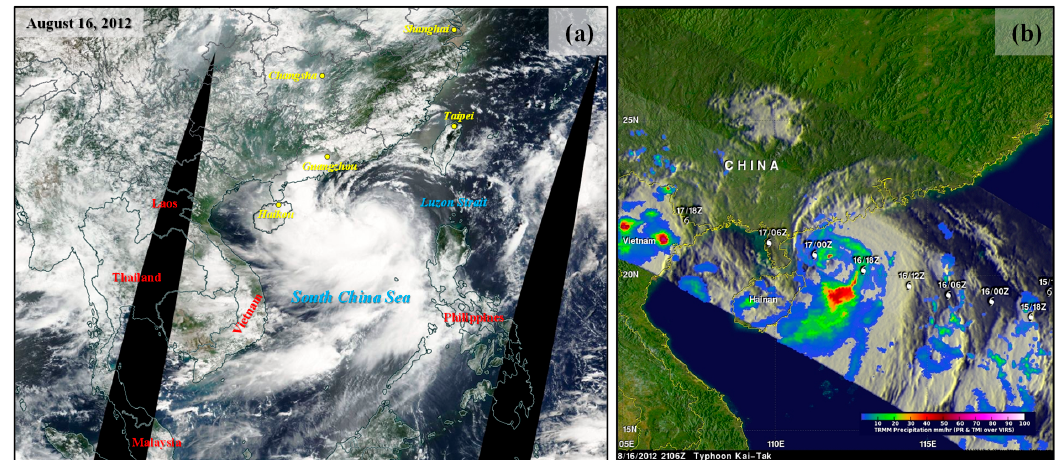
Figure 2. Typhoon Kai-tak. ( a ) Typhoon Kai-tak’s large reach from NASA’s Terra and Aqua satellites; ( b ) heaviest rainfall caused by typhoon Kai-Tak on the northwestern side (NASA).